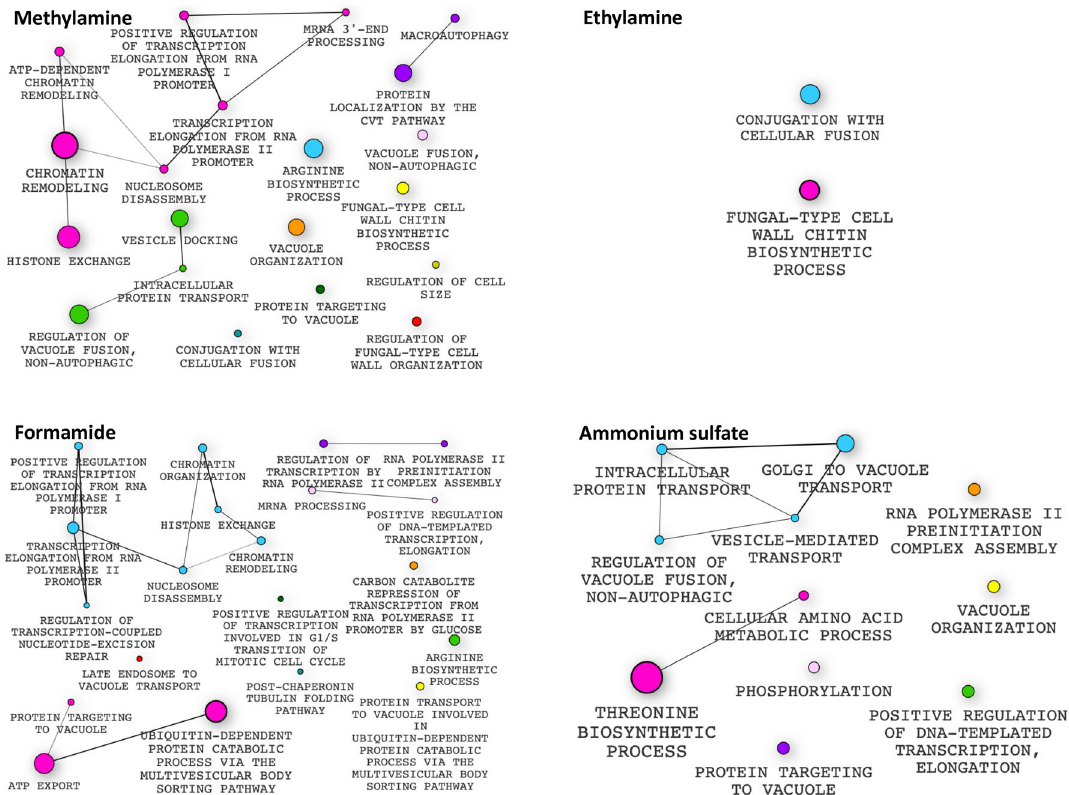
Figure 9. Gene ontology enrichment profiles showing pathways affected by the metabolic intermediates of N-nitrosamines. Genes deleted in strains that displayed increased sensitivity were enriched for certain